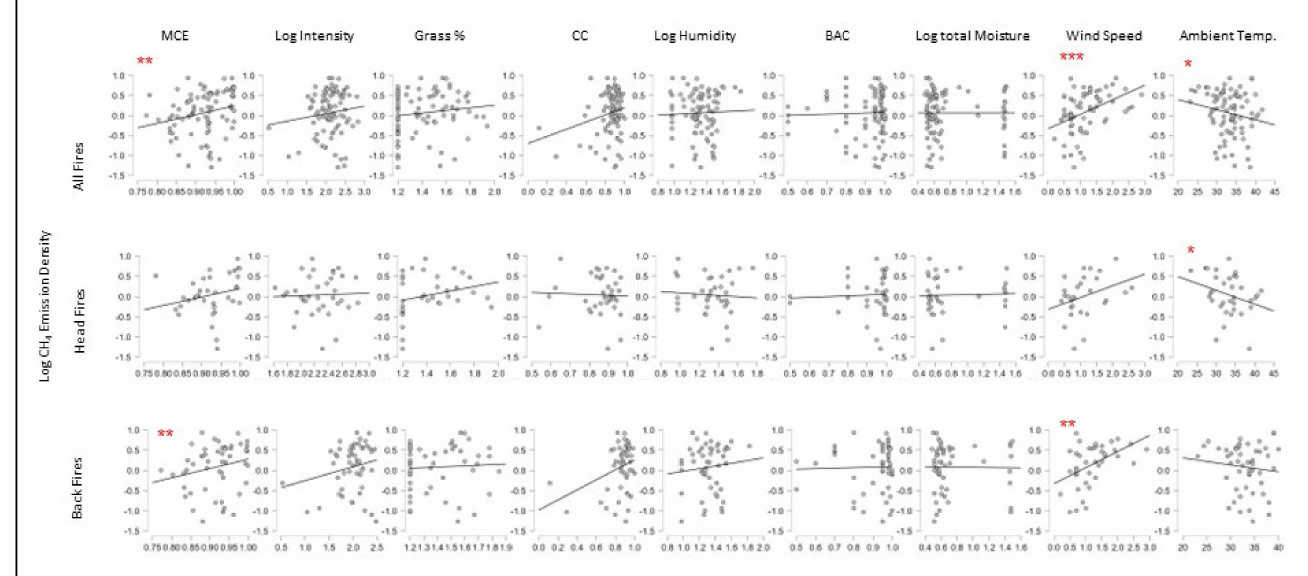
Figure 8. Methane Emission Factor ( Log) Correlation Plots for Key Variables by Fire Type (*** p < 0.001, ** p < 0.01, * p <